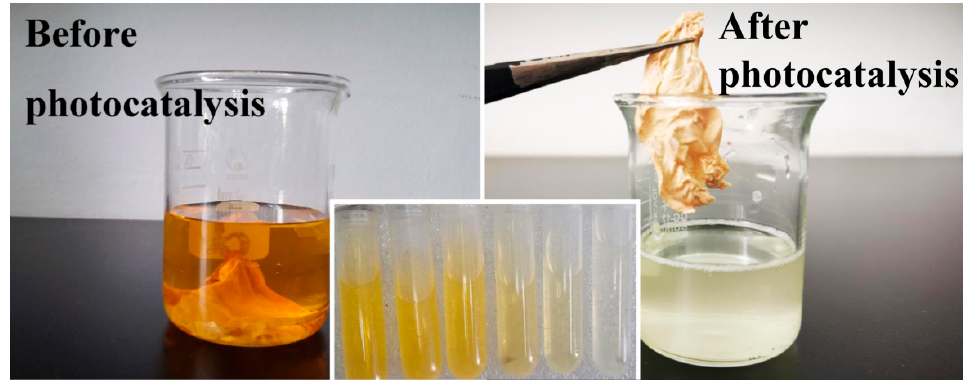
Figure 5. An optical image of macroscopical AgBr/BiOBr/PAN CMs removed from the photocatalytic reaction solution after photodegradation. reaction solution after photodegradation.